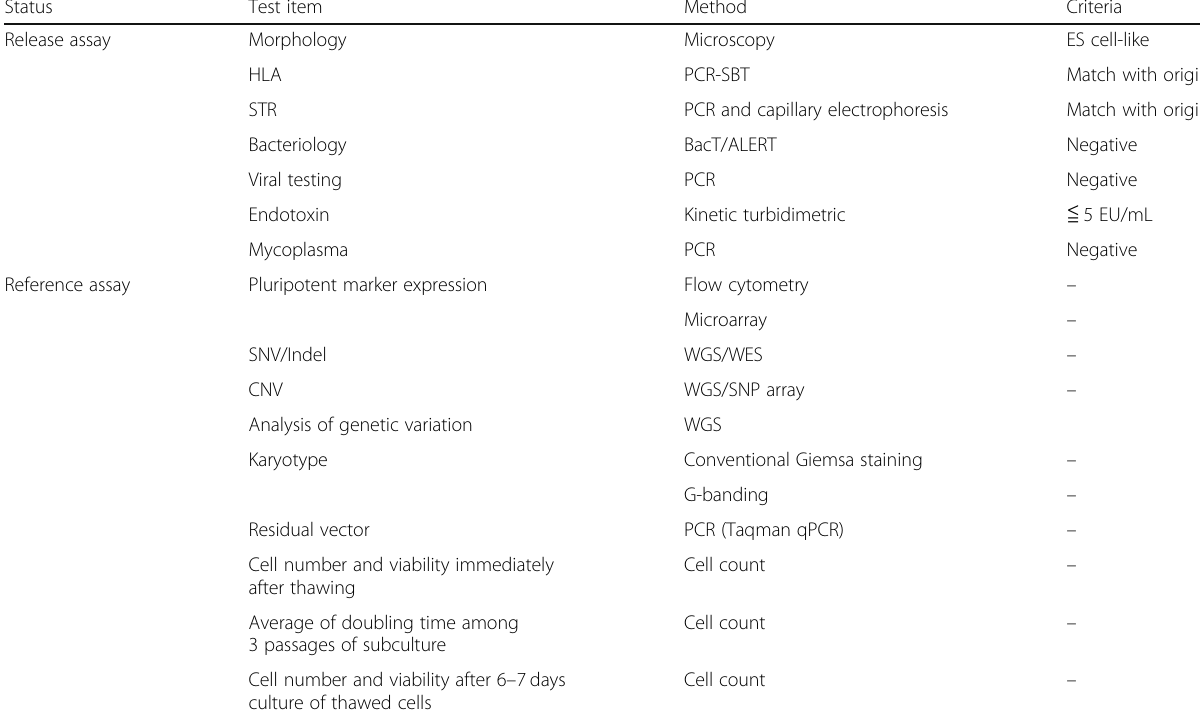
Table 2 Quality tested